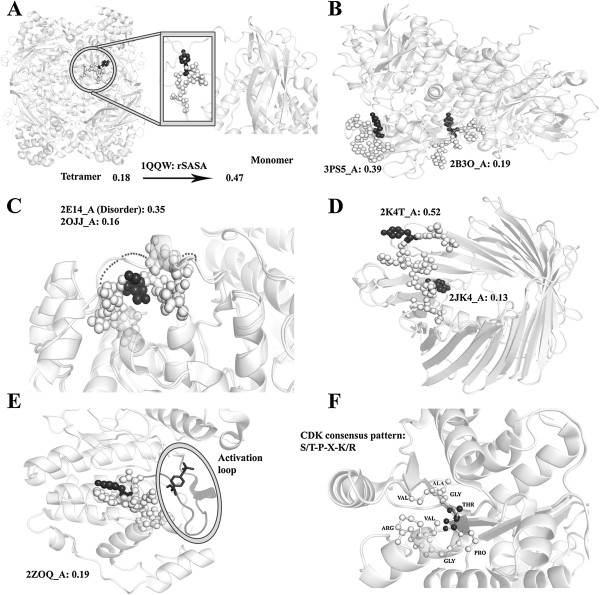
Structures of a phosphosite from the disallowed and allowed region of conformation. A) Phosphorylation site in Catalase, a homo tetramer (PDB ID: 1QQW) is buried at interface and has a calculated rSASA of 0.18. We extracted the monomeric form of this protein and recalculated the rSASA value which is now 0.47 indicating that the site is now accessible. B) Protein Tyrosine-protein phosphatase has two conformations in which the phosphorylation site is buried in an auto inhibited (PDB ID: 2B3O) conformation with a rSASA value of 0.19 and it is accessible to the solvent (rSASA of 0.39) in an open conformation (PDB ID: 3PS5). C) Two structures of Mitogen-activated protein kinase 1 are aligned where the phosphosite is present adjacent to a segment which is ordered in one PDB and is disordered (PDBID: 2E14) in another conformation. The disordered segment lacks coordinates for the overhanging loop. The phosphosite has greater rSASA (0.35) in the structure with the disordered segment than in the ordered structure (0.16). D) Two different conformations of Voltage-dependent anion-selective channel protein 1 in which the local structural changes were observed at the site of phosphorylation. In PDBID: 2JK4 phosphorylation site is buried inside channel (rSASA 0.13) whereas in PDBID: 2K4T phosphorylation the site is oriented outside (rSASA of 0.52). E) In Mitogen-activated protein kinase 3, the phosphosite is near to activation loop (rSASA 0.19). F) The phosphosite in Eukaryotic initiation factor has a known consensus pattern of S/T-P-X-K/R (rSASA 0.11) for Cyclin dependent kinase. The octapeptide is shown in ball and stick representation. In Figures A, B, C, D, E phosphosite is shown in ball and sphere notation and the phosphorylated residue is colored in black.